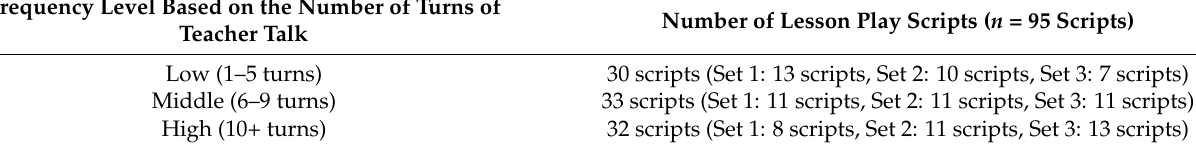
Table 3. Leveled frequency of teacher